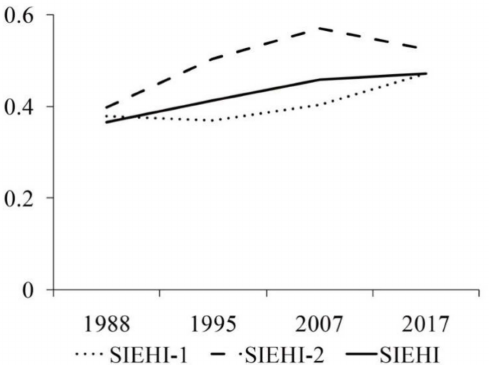
Figure 11. Overall changes of the sandy island ecosystem health from 1988 to 2017: SIEHI: sandy